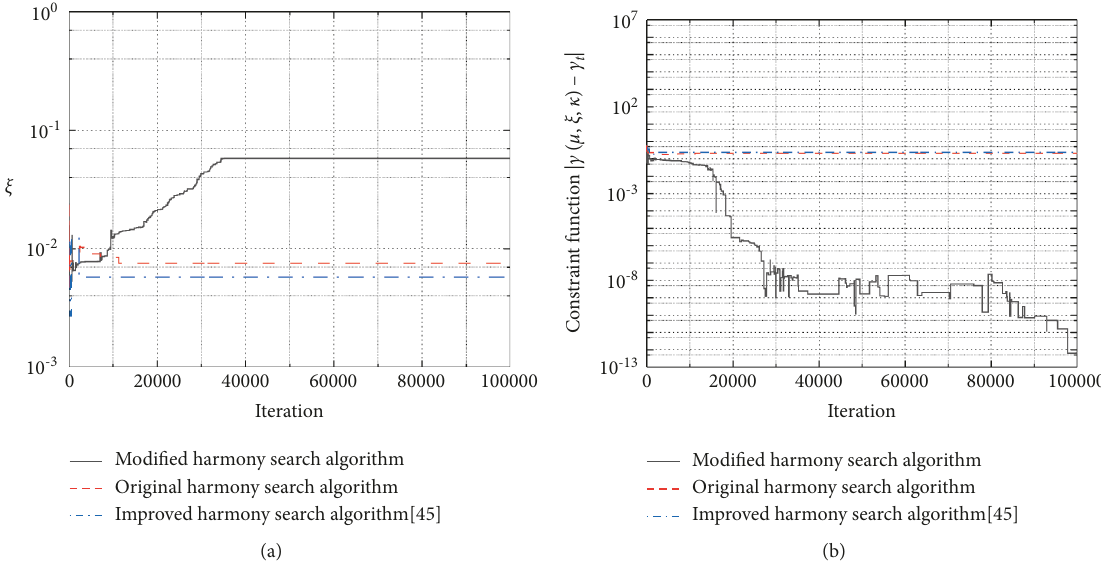
Figure 11: The variation trends of key indices during the optimization process for case 7. (a) The nominal damping ratio ξ . (b) The constraint function | c ( μ , ξ , κ ) − c t | .